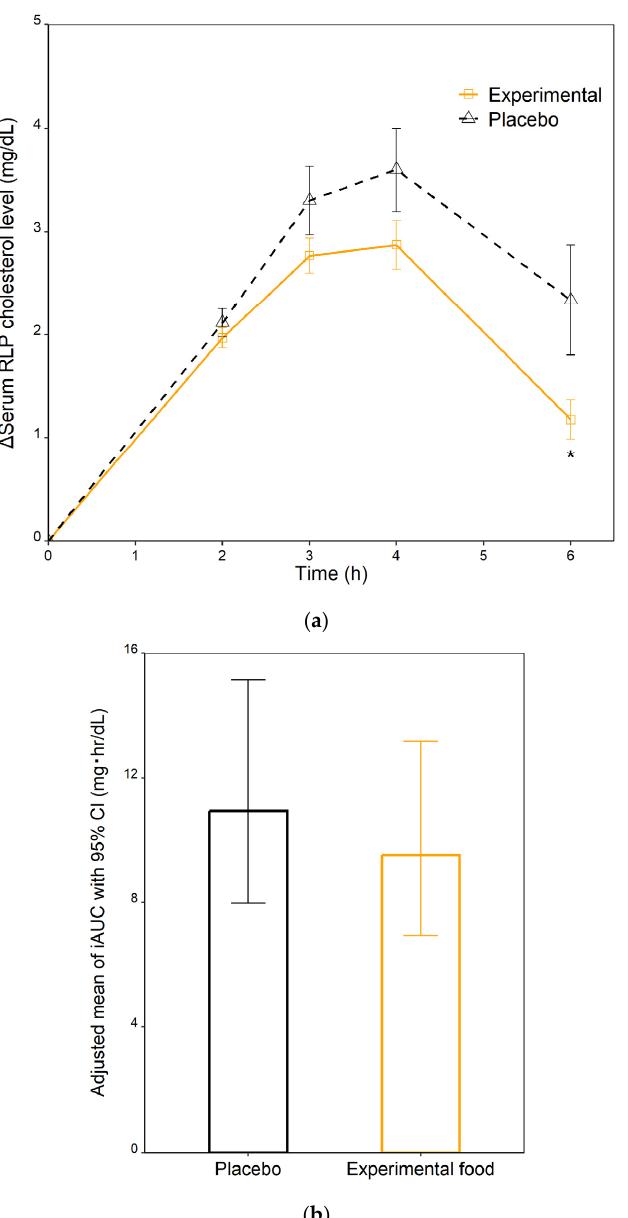
(1.18 vs. 2.34 mg/dL, p -value = 0.03) (Figure 4a). Comparison of the RLP cholesterol iAUCs adjusted for age, gender, BMI and sequence between the intervention arms are shown in Figure 4b. Treatment with the experimental food induced a nonsignificant reduction in the RLP cholesterol iAUC as compared to placebo (10.9 vs. 9.5 mg h/dL, p -value = 0.14). The effects of age, gender, BMI and sequence were insignificant.